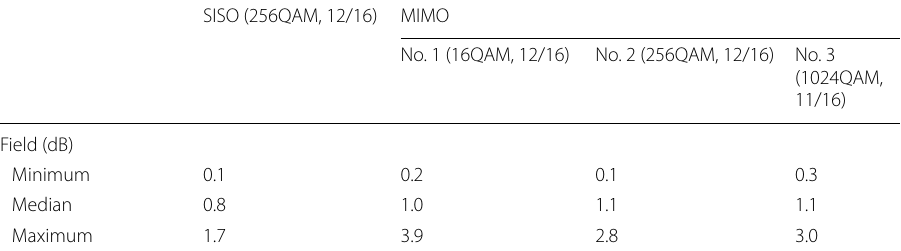
Table 7 Degradation in required received power measured in field experiments compared with laboratory